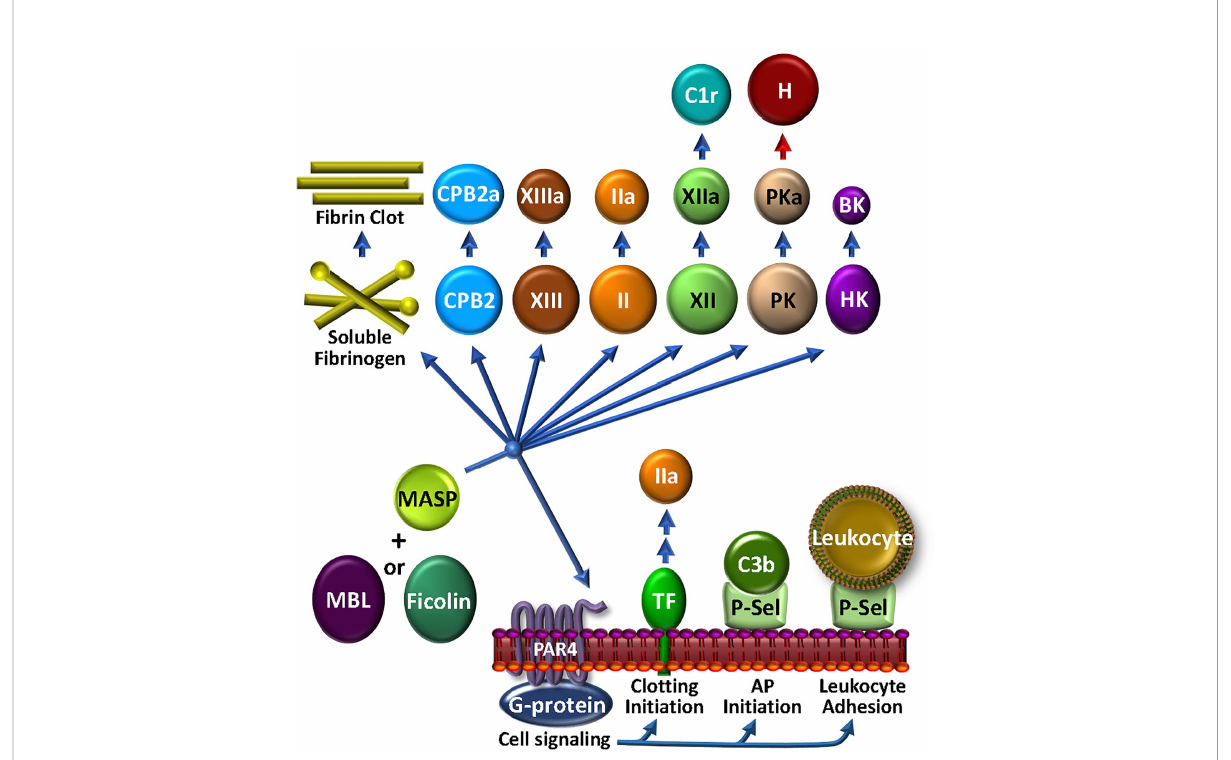
FIGURE 5 The MASP-Coagulation Web: MASPs may be either solution phase or surface bound, possibly associated with MBL, fi colin or collectin. Once triggered by engagement with an appropriate foreign lectin or other ligand, the activated MASP may stimulate cells via PAR4, leading to the availability of procoagulant TF or cell adhesive P-selectin activity. The latter may also participate to enhance AP C3 convertase assembly and function. MASPs have a wide array of circulating coagulation factor substrates, which may lead to bradykinin (BK) and kallikrein (PKa) that can inactivate factor H (H) and consequently up-regulate the AP, FXIIa that can activate C1r, thrombin (IIa), FXIIIa, carboxypeptidase 2 (CPB2), and fi brin